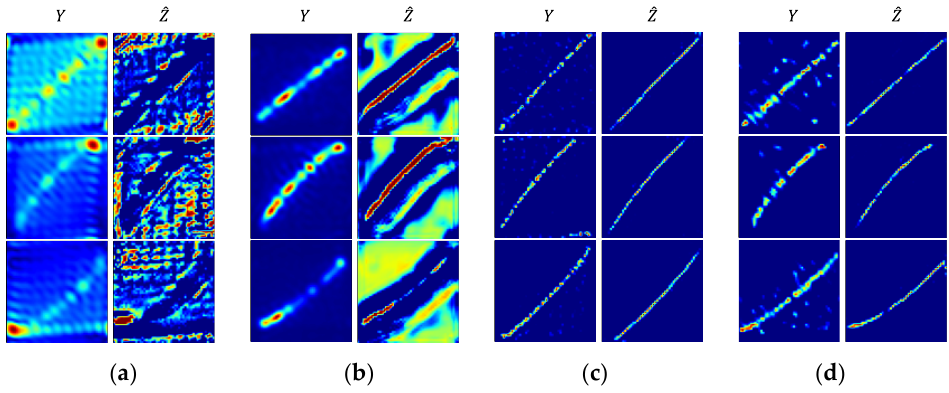
( b ) Figure 15. Computational complexities of different algorithms under different conditions: ( a ) the computational complexity varies with the iteration number and ( b ) the computational complexity varies with the array element number. 4.5. Rationality of DU-CG-STAP In the CycleGAN of DU-CG-STAP, the discriminator D Z learns the features of the high-accuracy clutter spectrum with the capacity to discriminate the true and fake spectra, which is continuously improved based on the unpaired dataset. At the same time, the generator G YZ is committed to mapping the low-accuracy clutter spectrum into the high- accuracy domain. If the low-accuracy clutter spectrum is provided with poor quality, it will be difficult for CycleGAN to extract the clutter features and complete the high-accu- racy reconstruction task in the unsupervised training process. Hence, to illustrate the ra- tionality of the DU-CG-STAP processing framework, the following results are provided. In the proposed processing framework, the low-accuracy clutter spectrum dataset is generated by the self-supervised trained 2DMA-Net and used as the input data for Cy- cleGAN. If the low-accuracy clutter spectrum dataset is generated by some low-accuracy